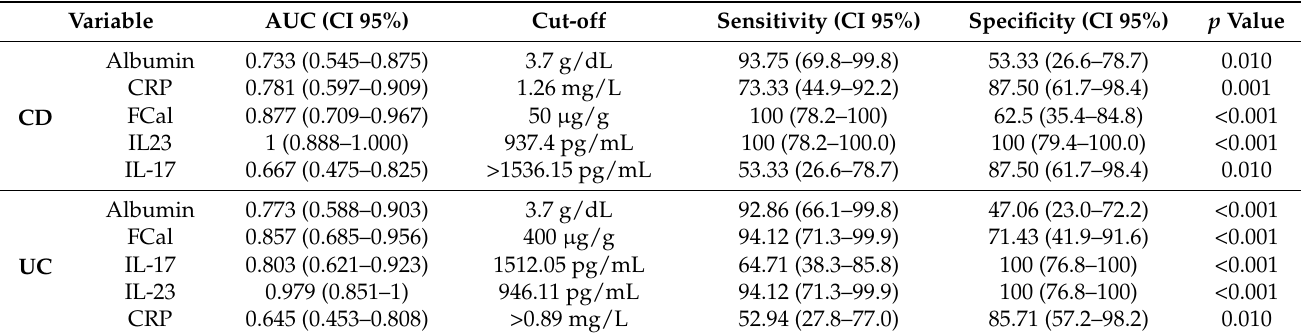
Table 2. AUC values for assessing disease severity.